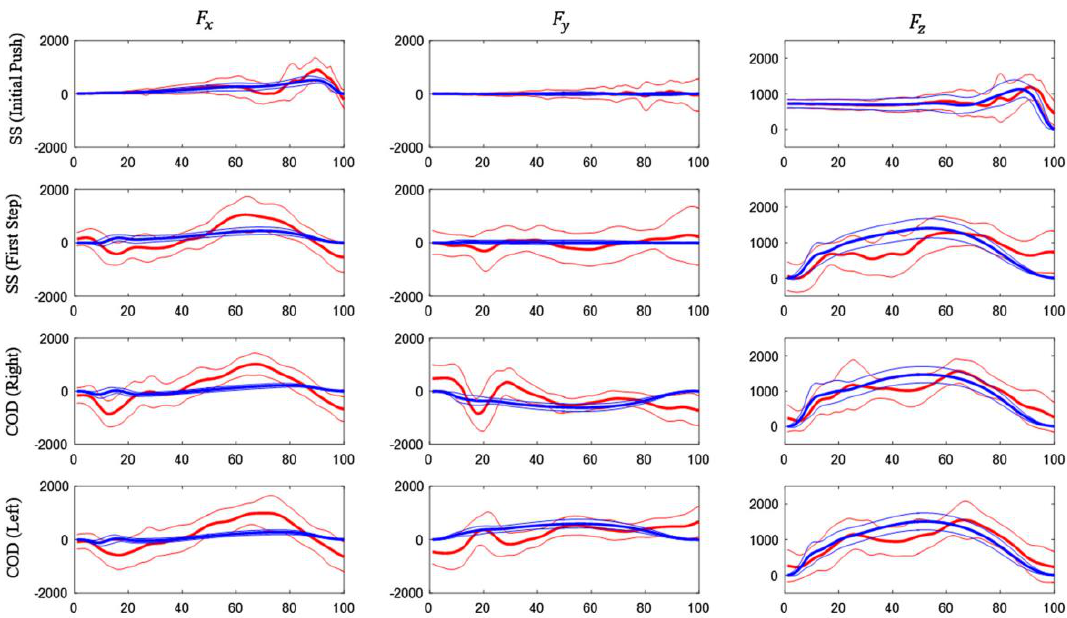
Figure 10. Graphical representation of the GRF curves along the gait cycle for IMU (red) and FP (blue) as found by [56]. (SS) sprint start task, (COD) change of direction tasks. F z is the vertical component.